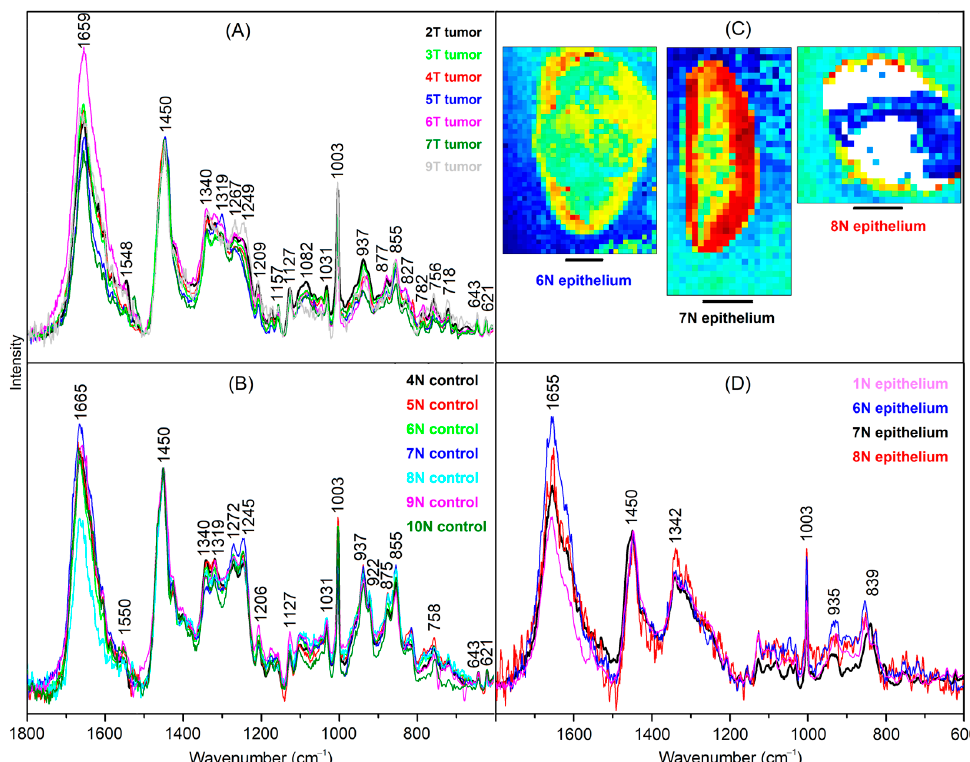
Figure 4. Endmember spectra obtained from VCA of bladder tumor ( A ), control bladder tissue ( B ) and epithelium ( C ). Scale bar = 2 mm ( D ). Spectra are baseline-corrected, normalized and overlaid for comparison. Abundance plots were included for epithelium endmembers.